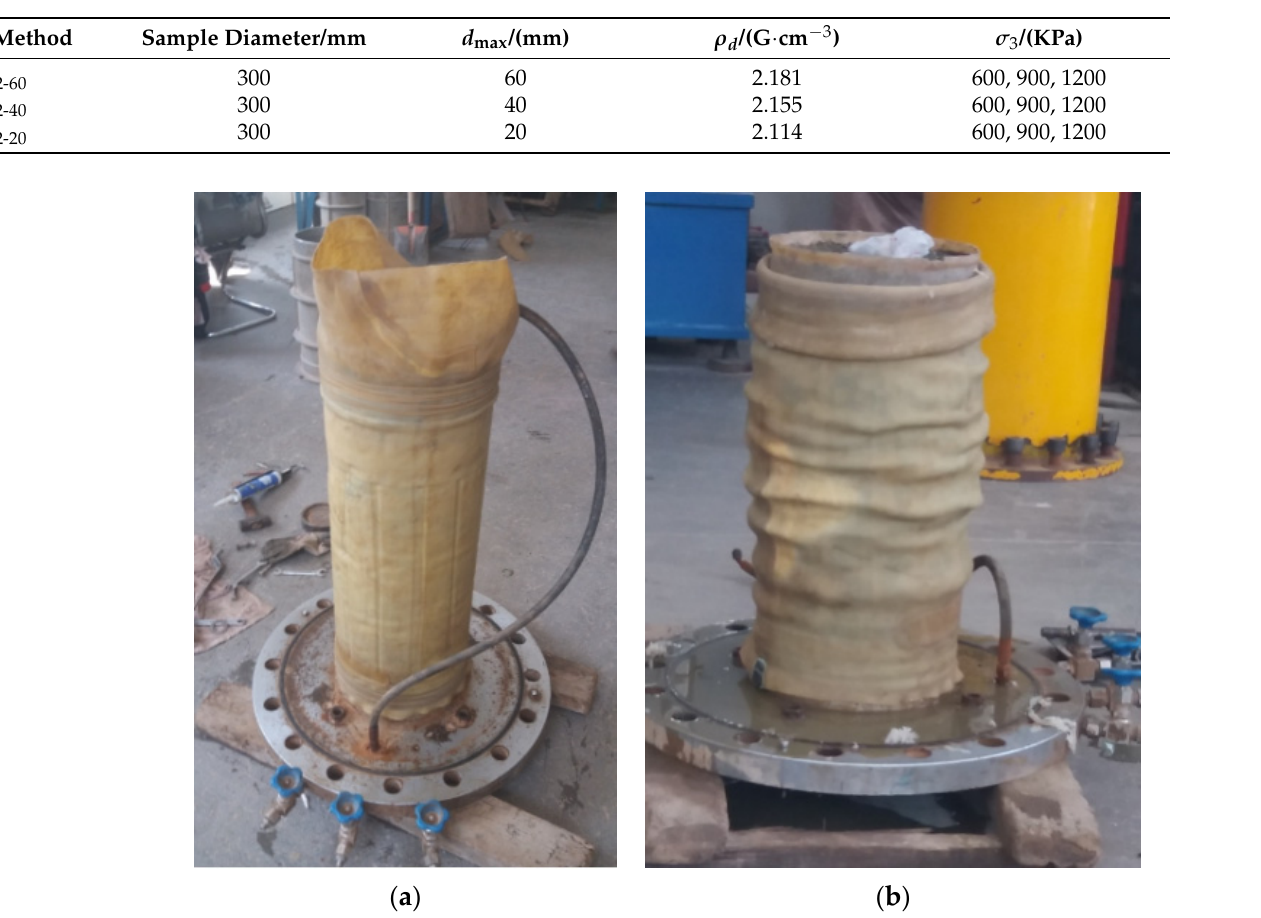
Figure 3. Typical photographs of the sample before and after the test ( σ 3 = 600 kPa). ( a ) Loading sample. ( b ) Failure specimen.